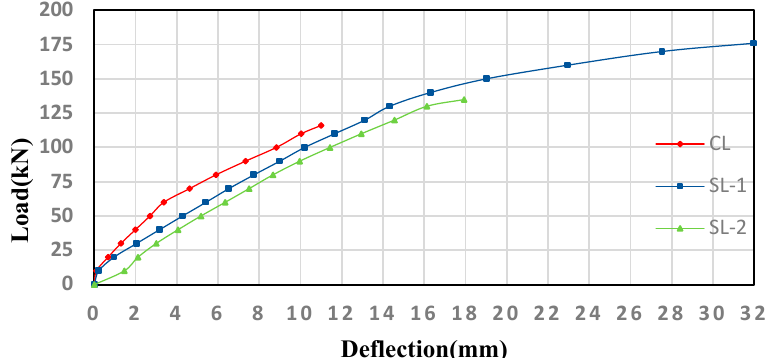
Figure 8. Load–deflection curve for beams of group L.